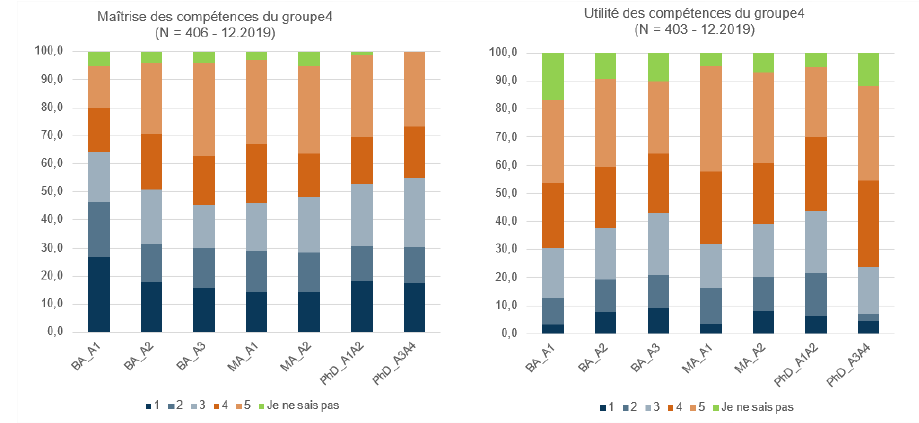
Fig. 3 Answers of the students to mastering and utility of Collaboration digital